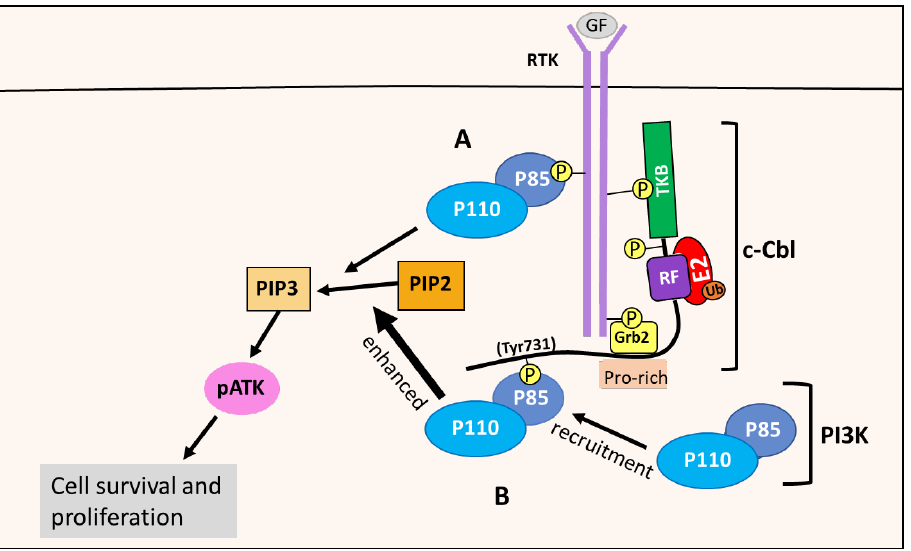
Figure 14. c-Cbl enhances the PI3K/AKT pathway via PI3K recruitment. ( A ) RTK activation allows the p85 regulatory subunit of PI3K to bind to the phosphor-tyrosine residues of RTKs. This interaction relieves the p85 suppression of the p110 catalytic subunit, and allows PI3K to phosphorylate PIP2 to PIP3, initiating the PI3K/AKT pathway that leads to cell survival and proliferation. ( B ) c- Cbl’s Tyr73 1 residue is phosphorylated after RTK stimulation, enabling it to bind and recruit PI3K via the p85 regulatory subunit. This results in enhanced PIP2 phosphorylation and PI3K/AKT pathway acti- vation, and thuss promotes cellular survival and proliferation.